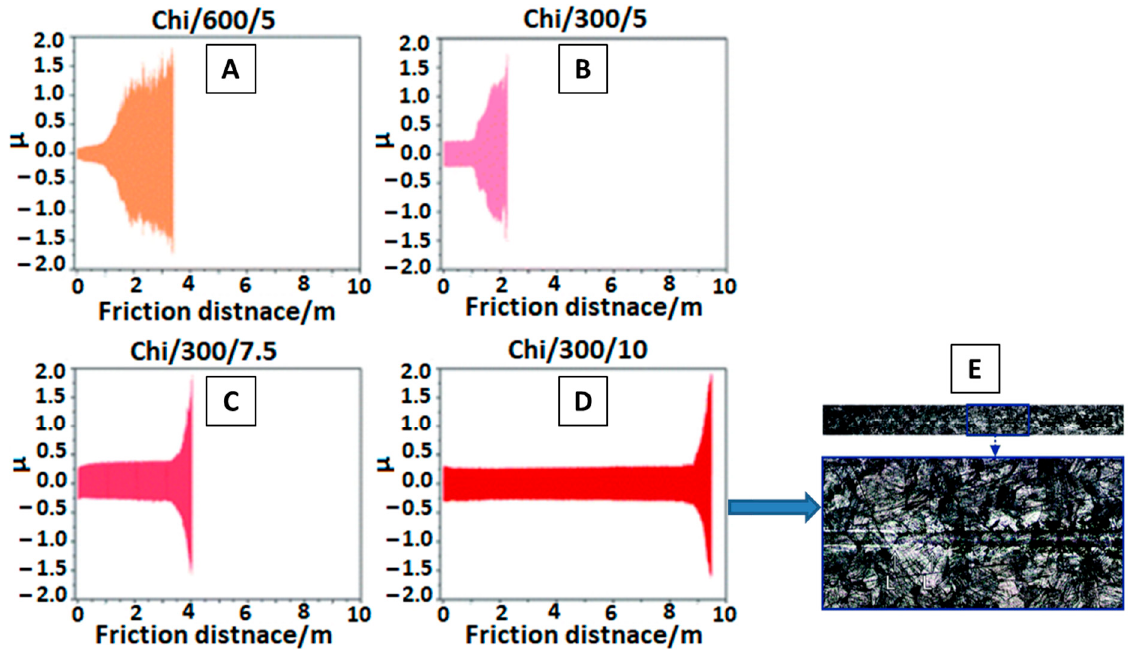
Figure 12. ( A – D ) Variation in friction co-efficient of chi coating at different time(s)/voltage(V), ( E ) SEM of chi deposited at 10V for 300s. Reproduced from [82] with the permission from the Royal Society of Chemistry™.